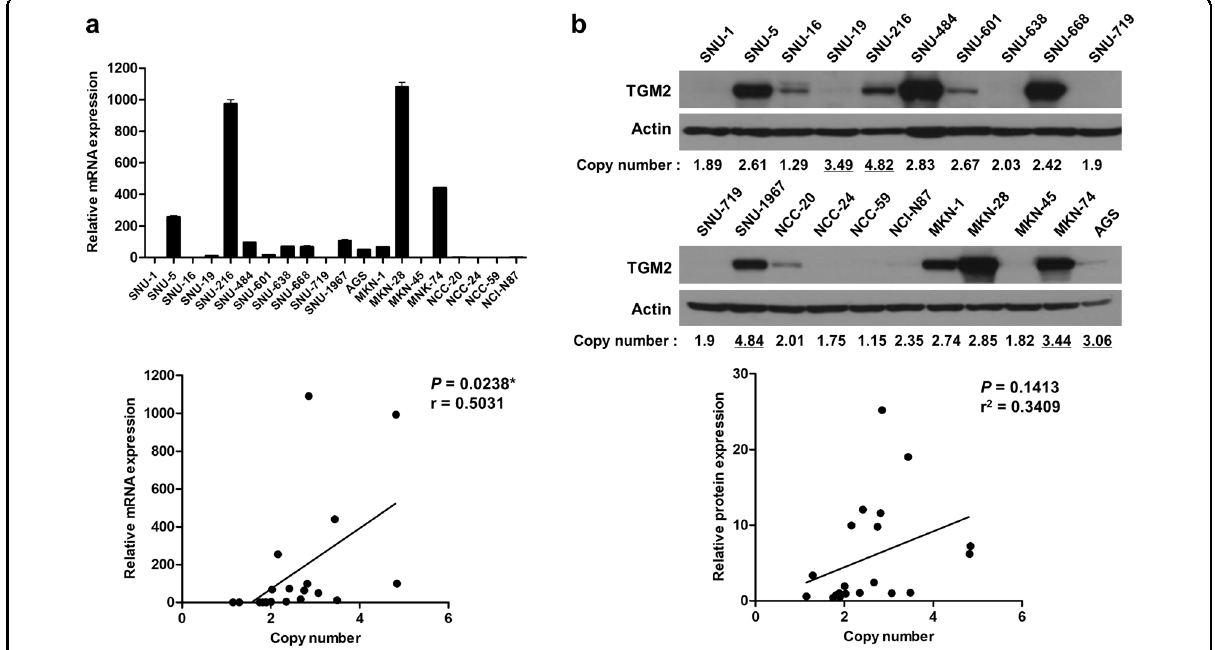
Fig. 2 The correlation between TGM2 expression levels and TGM2 copy numbers in GC cell lines. a The mRNA expression levels and copy numbers of TGM2 in 20 GC cell lines. The messenger RNA expression levels of TGM2 were quanti fi ed by real-time PCR (upper panel), and the copy number values of TGM2 were estimated by ddPCR. The lower panel shows the correlation between the mRNA expression levels and copy numbers of TGM2 in the GC cell lines, and the P -value determined by linear regression (* P < 0.05) and Pearson correlation coef fi cient ( r ) are indicated. b Protein expression levels and copy numbers of TGM2 in 20 GC cell lines. The protein levels of TGM2 were evaluated by western blot analysis, and the copy number values of TGM2 were estimated by ddPCR (upper panel). The underlined numbers represent the TGM2-ampli fi ed samples (threshold cut-off of 3.0 copies). The lower panel shows the correlation between the protein expression levels and copy numbers of TGM2 in the GC cell lines. The protein expression levels were quanti fi ed by densitometric analysis for western blotting using ImageJ. The correlation between gene expression and copy number was estimated by linear regression analysis, and the Pearson correlation coef fi cient ( r ) is